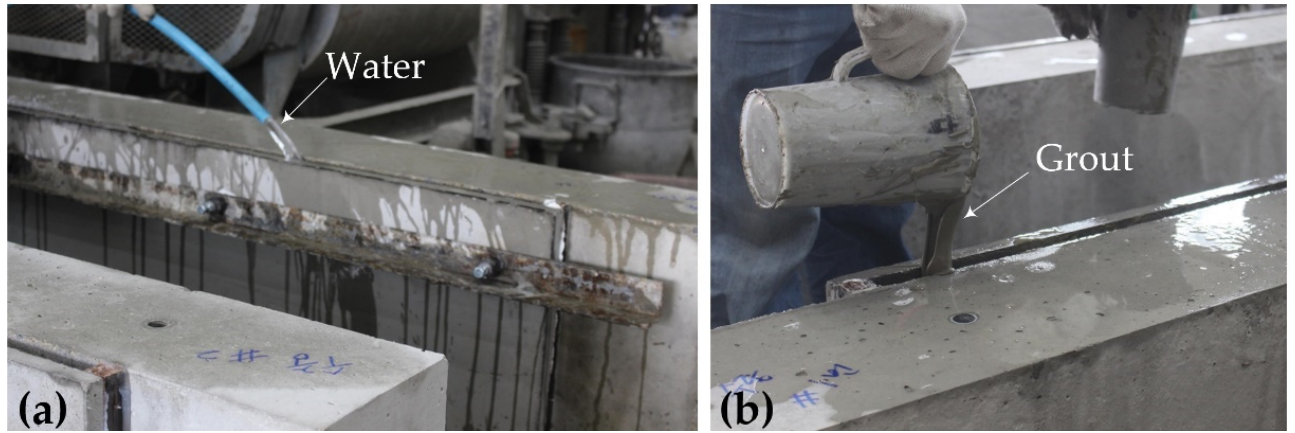
Figure 10. TRC grouting process: ( a ) Water filling; ( b ) grouting.